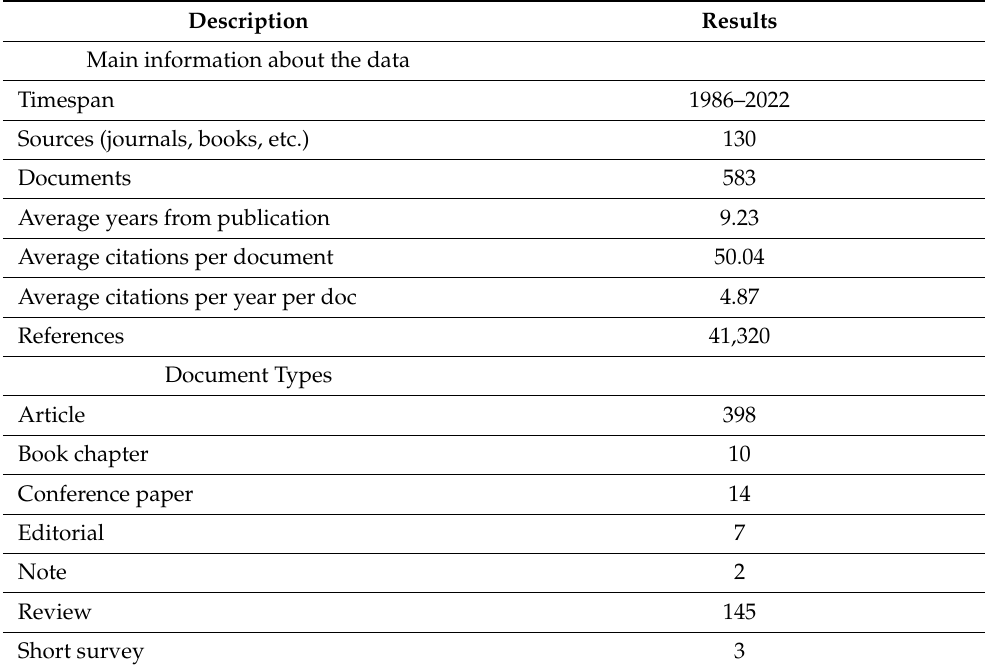
Figure 1. PRISMA Figure 1. PRISMA flow. Table 1. Data description.